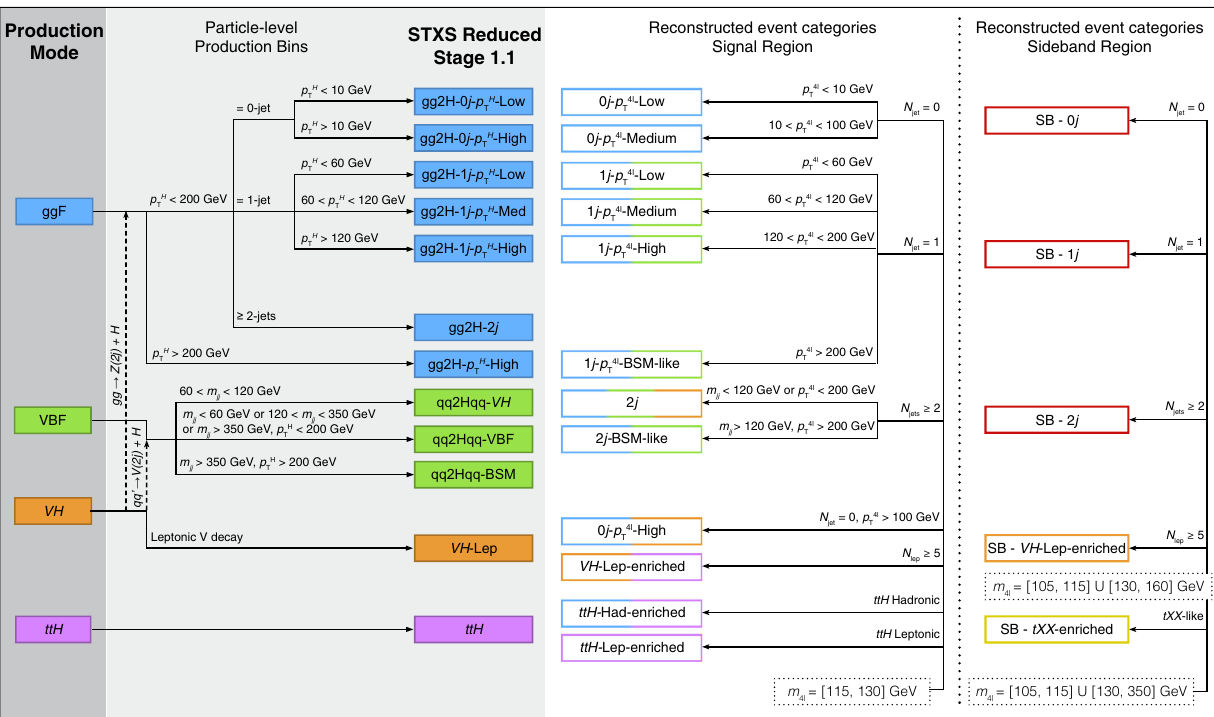
Fig. 1 Two sets (Production Mode Stage and Reduced Stage 1.1) of exclusivephase-spaceregions(productionbins)definedatparticle-level for the measurement of the Higgs boson production cross-sections (left and middle-left shaded panels), and the corresponding reconstructed event categories for signal (middle-right panel) and sidebands (right panel). The description of the production bins is given in Sect. 1.1,